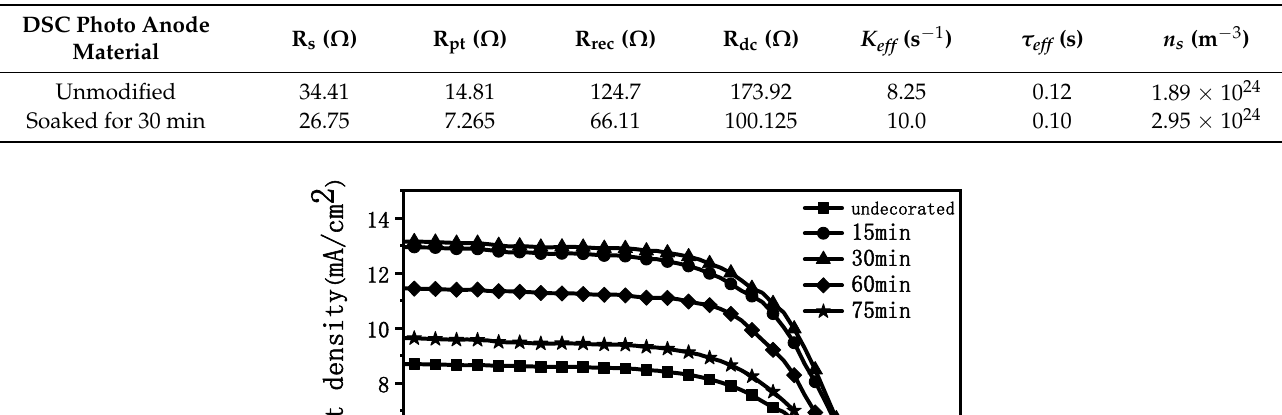
Figure 12. EIS results of DSC after assembly of anode films: (a) without modification; (b) modified by soaking in 40 mM TiCl 4 aqueous solution at 70 °C for 30 min. Table 2. Electron transport kinetics microscopic parameters of DSC before and after adding TiO 2 particle surface ‐ modification layer.